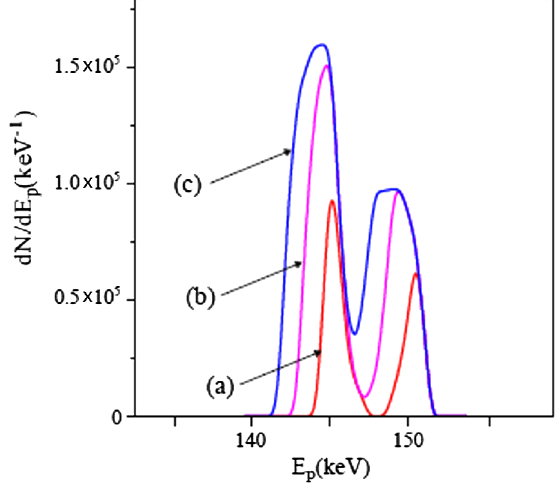
FIG. 4. Spectral density S ¼ dN=dE p as a function of E p in the case of beam (A) for different acceptance angles: